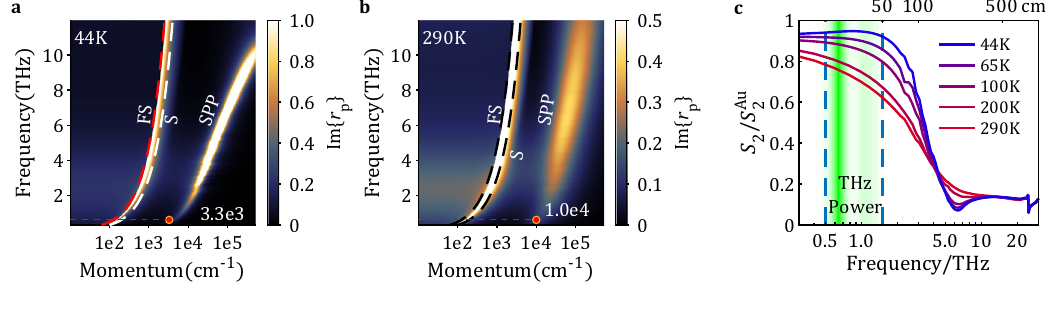
Fig. 3 Electrodynamics and plasmonic response of 3L WTe 2 . Modeled imaginary part of the momentum dependent p-polarized re fl ection coef fi cient r ð ω ; q Þ at a 44 K and b 290 K, based on bulk dielectric function data 21 . The red points located at q ¼ 3 : 3 e 3cm (cid:3) 1 ( λ ¼ 19 μ m) and q ¼ 1 : 0 e 4cm (cid:3) 1 p ( λ ¼ 6 : 3 μ m) indicate the momentum of SPP at 0.6 THz. Free space (FS) and SiO 2 (S) light lines are indicated with dashed lines, respectively. SPP dispersions are clearly observed, and the dispersion broadens with increasing temperature. c Spectra of the near- fi eld scattering amplitude modeled following McLeod et al. 45 at different temperatures based on calculated r p ð ω ; q Þ . The shaded area indicates the frequency spectrum of our THz